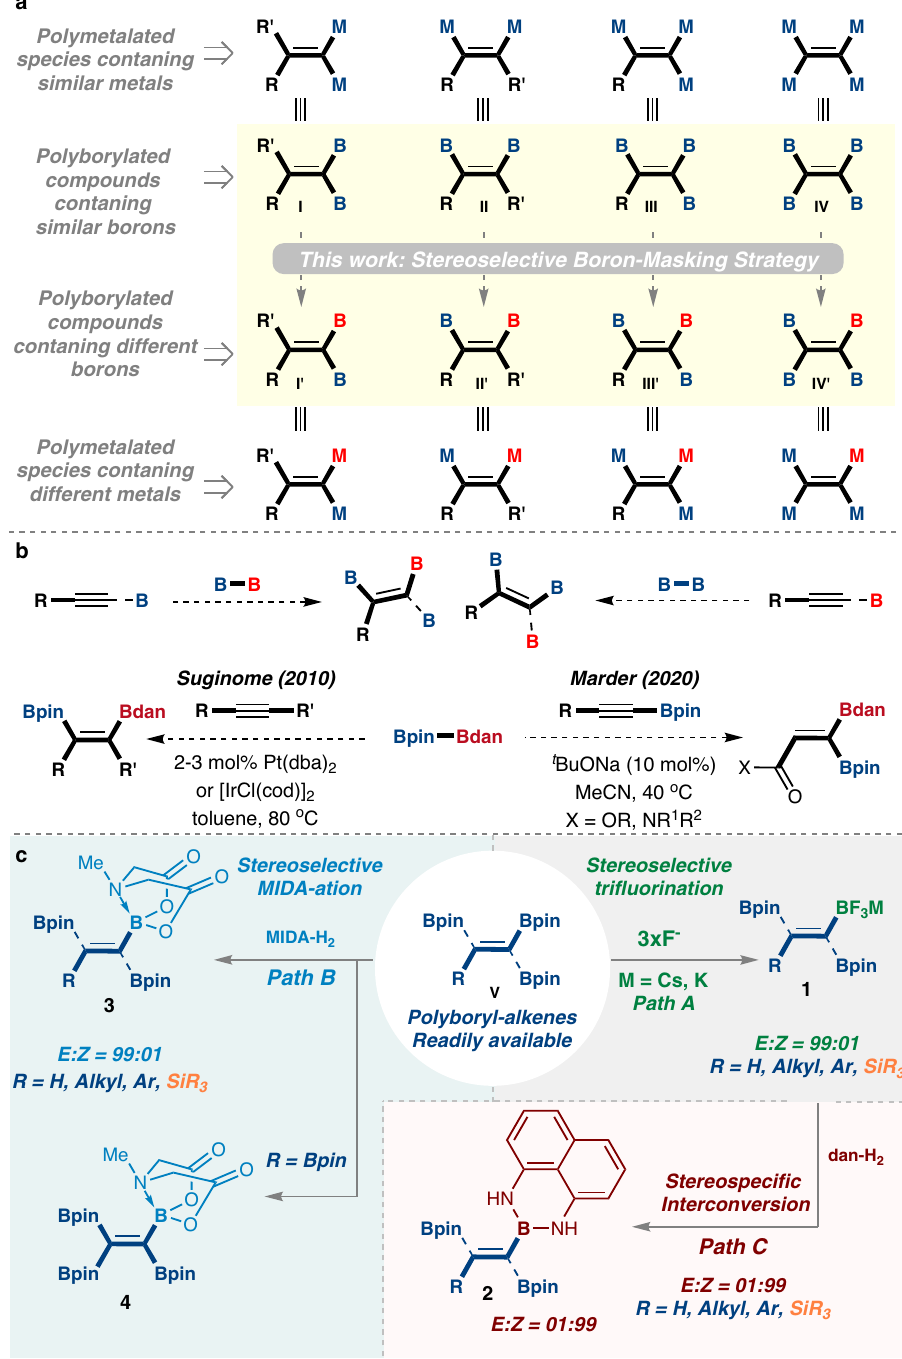
Fig. 1 | General scheme of the work. a Classifying of polyborylated and poly- metalated compounds. b Representative routes for making mixed polyborylated- alkenes. c General scheme of the presented approaches for the stereoselective boron-masking of polyborylated-alkenes includes the tri fl uorination, MIDA-ation,